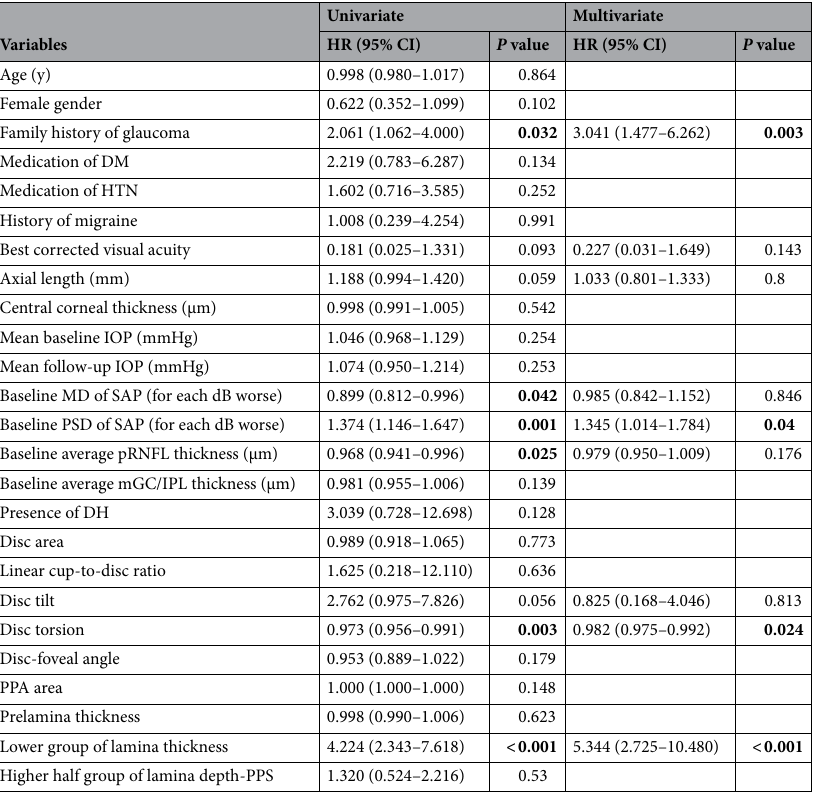
Table 7. Factors associated with progression to NTG in NTG suspect patients with myopia. HR, hazard ratio; CI, confidence interval; DM, diabetes mellitus; HTN, systemic hypertension; pRNFL, peripapillary retinal nerve fiber layer; mGC-IPL, macular ganglion cell-inner plexiform layer; IOP, intraocular pressure; MD, mean deviation; PSD, pattern standard deviation; dB, decibel; MD, mean deviation; SAP, standard automated perimetry; DH, disc hemorrhage; PPA, peripapillary atrophy; PPS, peripapillary sclera. Factors with P < 0.1 in univariate analysis were included in multivariate analysis. Data are mean ± standard deviation unless otherwise indicated. Factors with statistical significance are shown in